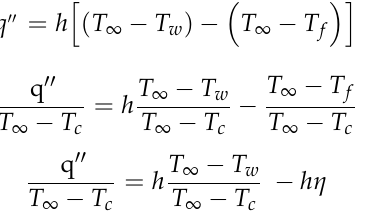
Table 1. Experimental conditions.